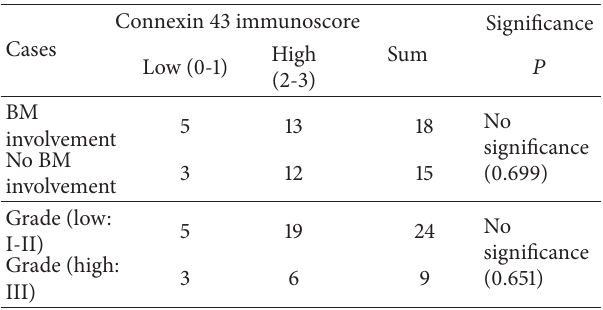
Table2:Connexin43proteinexpressioninrelationtobonemarrow (BM) involvement and grade of follicular